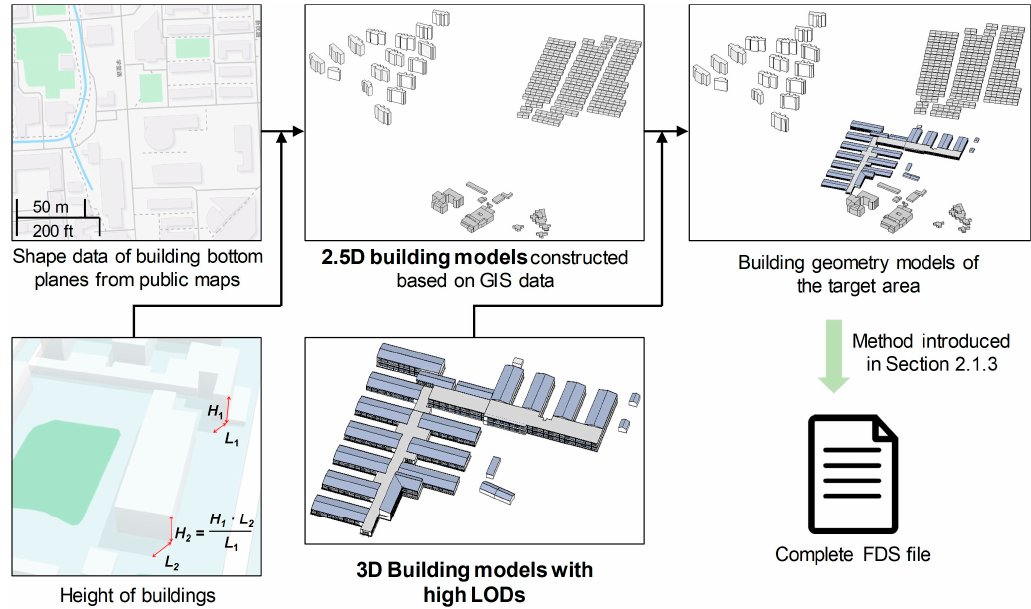
Figure 5. High-e ffi ciency modeling method based on BIM and geographic information system (GIS) Figure 5. High-efficiency modeling method based on BIM and geographic information system (GIS) data for the FDS model of the target data for the FDS model of the target area.